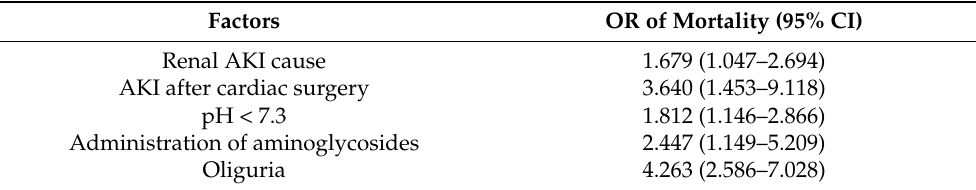
Table 4. Associations of variables and mortality of patients with dialysis-dependent acute kidney injury in the model of multivariable logistic regression analysis. (Model